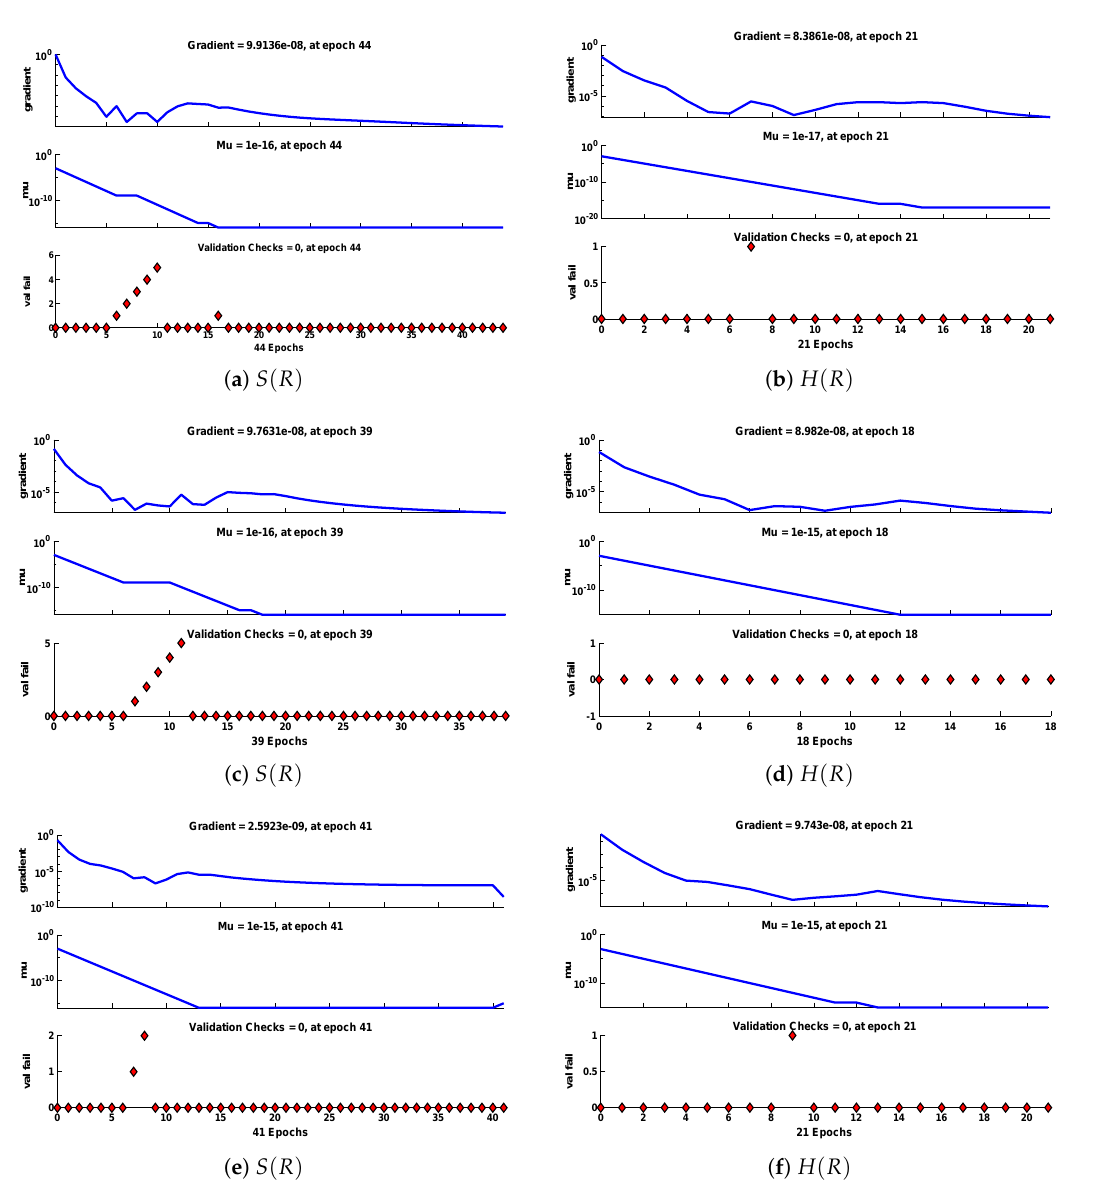
Figure 12. Performance of NNs–LM based on gradient, mu and validations failure during the process of optimization for different cases of Scenario